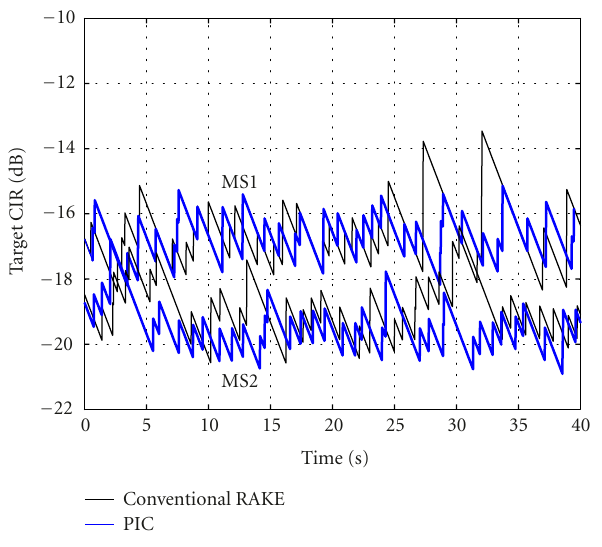
Figure 13: RNC (layer 3) target CIR commands when either con- ventional RAKE or PIC receiver is utilized for users 1 and 2.